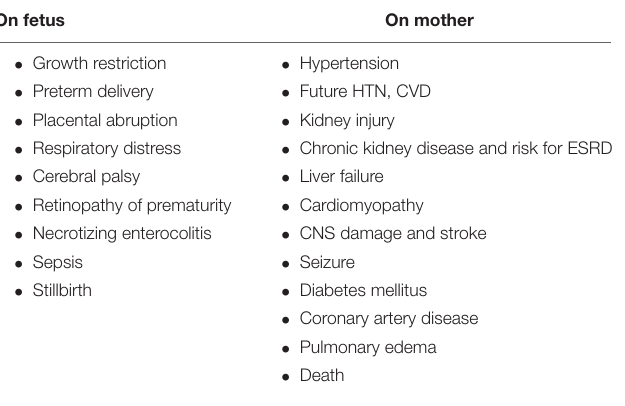
TABLE 1 | Adverse impact of preeclampsia on fetus and mother. On fetus On